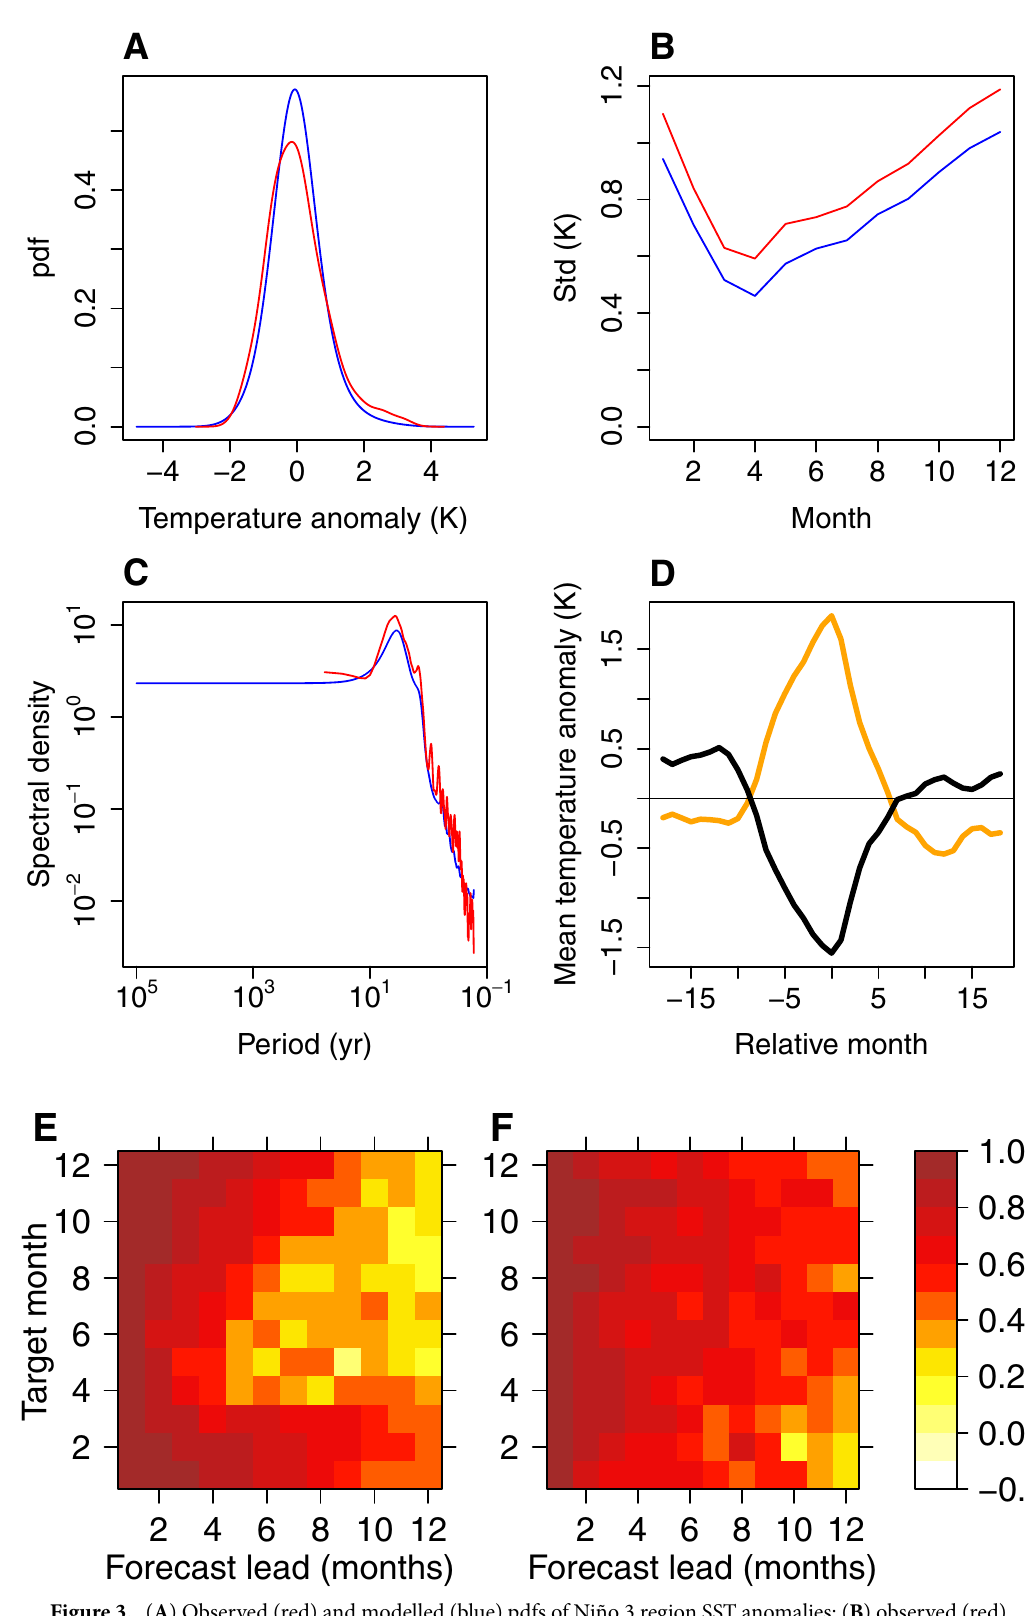
Figure 3. ( A ) Observed (red) and modelled (blue) pdfs of Niño 3 region SST anomalies; ( B ) observed (red) and modelled (blue) standard deviations of the SST anomalies for different months; ( C ) observed (red) and modelled (blue) spectra of the SST anomalies; ( D ) composite plot for modelled SST anomalies for warm (orange) and cold (black) events for months relative to the December of each event; and correlation coefficient between predicted and observed SST ( E ) and thermocline depth ( F ) anomalies for seasons centered on various target months and for different forecast lead